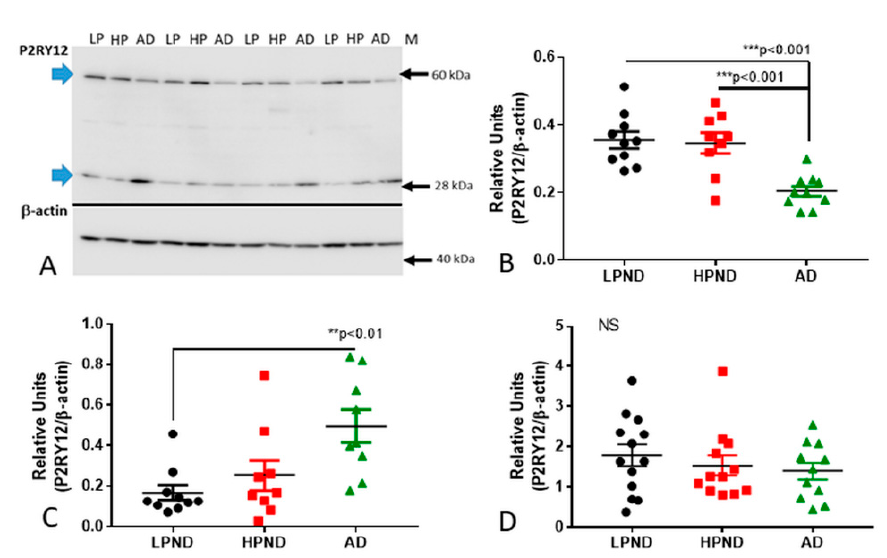
Figure 2. Quantitative biochemical measurements of P2RY12 protein and mRNA in human brains. ( A–C ). Western blot measurements of P2RY12 levels in MTG samples from LP, HP and AD brains. ( A ). Representative western blot image of P2RY12 polypeptide of MTG protein extracts identified with Novus antibody. Blots were normalized for levels of β actin. ( B ). Scatter plot showing individual P2RY12 expression levels. Significant decrease in protein levels of 58 kDa full-length P2RY12 band in AD (green shapes) compared to LPND (black) and HPND (red) cases. Chart indicates mean + Standard error of mean (SEM). Statistical analysis by one-way ANOVA with Tukey post-hoc test (F 2,26 = 11.54, p < 0.001). ( C ). Scatter plot showing significant increase in protein levels of 30 kDa cleaved P2RY12 band in AD cases compared to LPND cases. Statistical analysis by one-way ANOVA with Tukey post-hoc test (F 2,26 = 5.649, p < 0.01). Bar chart indicates mean + SEM. ( D ). Scatter plot showing expression levels of P2RY12 mRNA (normalized for β actin mRNA) in MTG samples. Lack of significant difference in expression of P2RY12 mRNA between LPND, HPND, and AD cases (MTG set 2). Samples measured by real time polymerase chain reaction. Statistical analysis by one-way ANOVA with Tukey post-hoc test (F 2,32 = 1.031, p >0.05). Abbreviations: LPND: low plaque non-